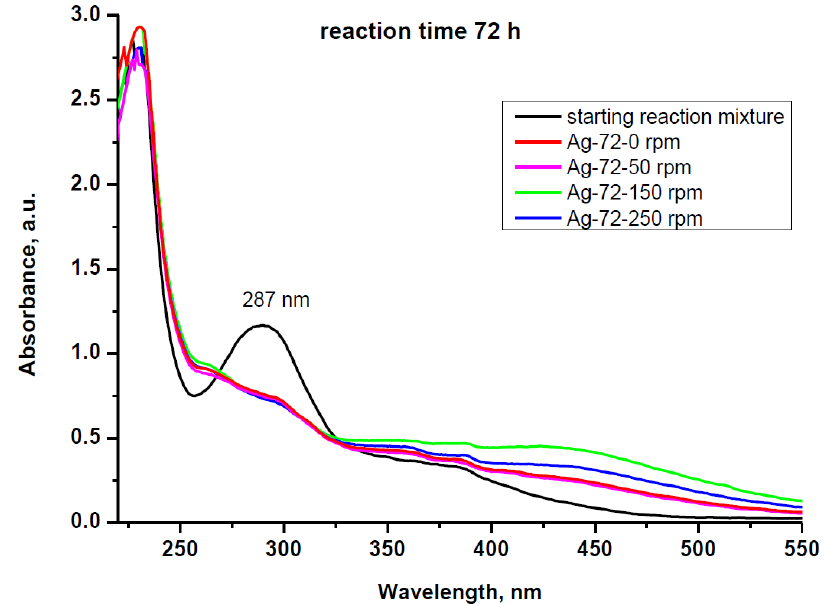
Figure 7. UV–Vis spectra of the starting reaction mixture and the reaction mixtures kept under static conditions (Ag-72-0 rpm) and stirring with different rotation speeds (50, 150 and 250 rpm) for reaction time 72 h. The temperature was kept constant (30 ± 1 ° C).